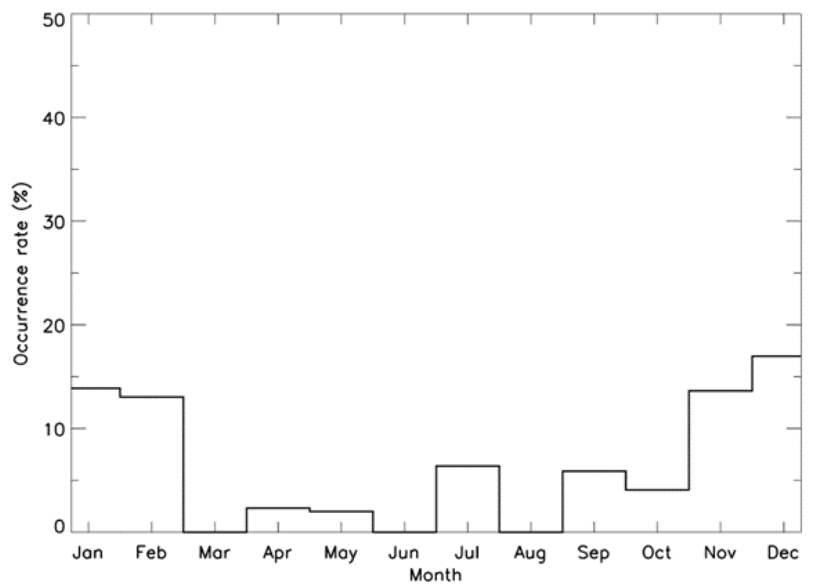
Figure 2. Seasonal variation in the occurrence rate of equatorial spread F (ESF) structures observed inside the field of view of the Arecibo all-sky imager during the 2002–2007 period. A main peak is clearly observed during the December solstice.